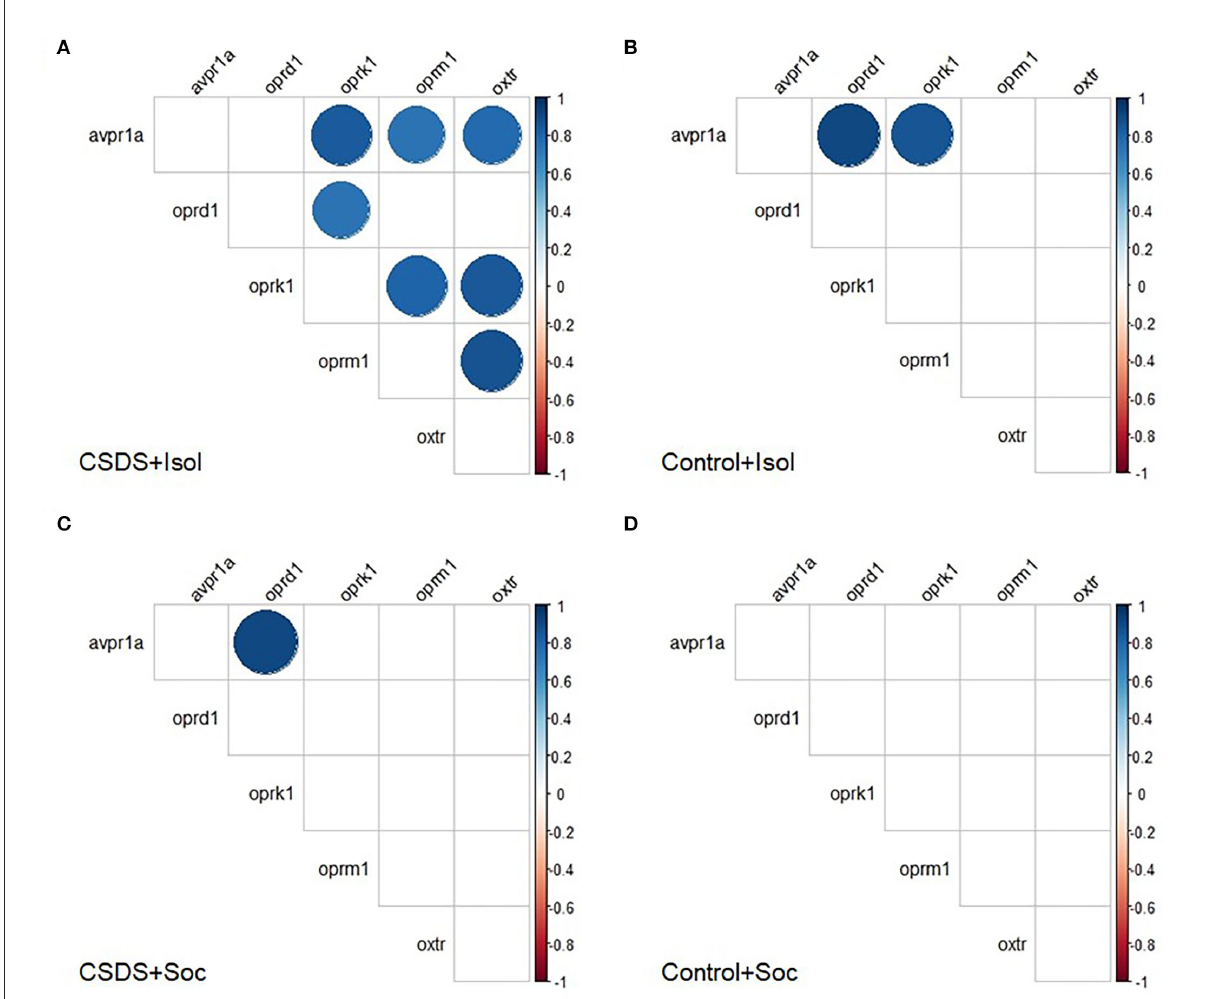
FIGURE6 Correlograms separated by group. Pair-wise Pearson correlations with false discovery rate were calculated for mRNA expression and all correlations plotted for the (A) CSDS + Isol, (B) Control + Isol, (C) CSDS + Soc, and (D) Control + Soc subjects. Positive correlations are displayed in blue and negative correlations in red color. Color intensity and the size of the circle are proportional to the correlation coefficients. In the right side of each correlogram, the legend color shows the correlation coefficients and the corresponding colors. Statistically non-significant correlations are left blank. The FDR adjusted alpha was α < 0.01 for Control + Isol, α < 0.005 for Control + Soc, α < 0.035 for CSDS + Isol, and α < 0.005 for CSDS-Soc (Benjamini and Hochberg, 1995).